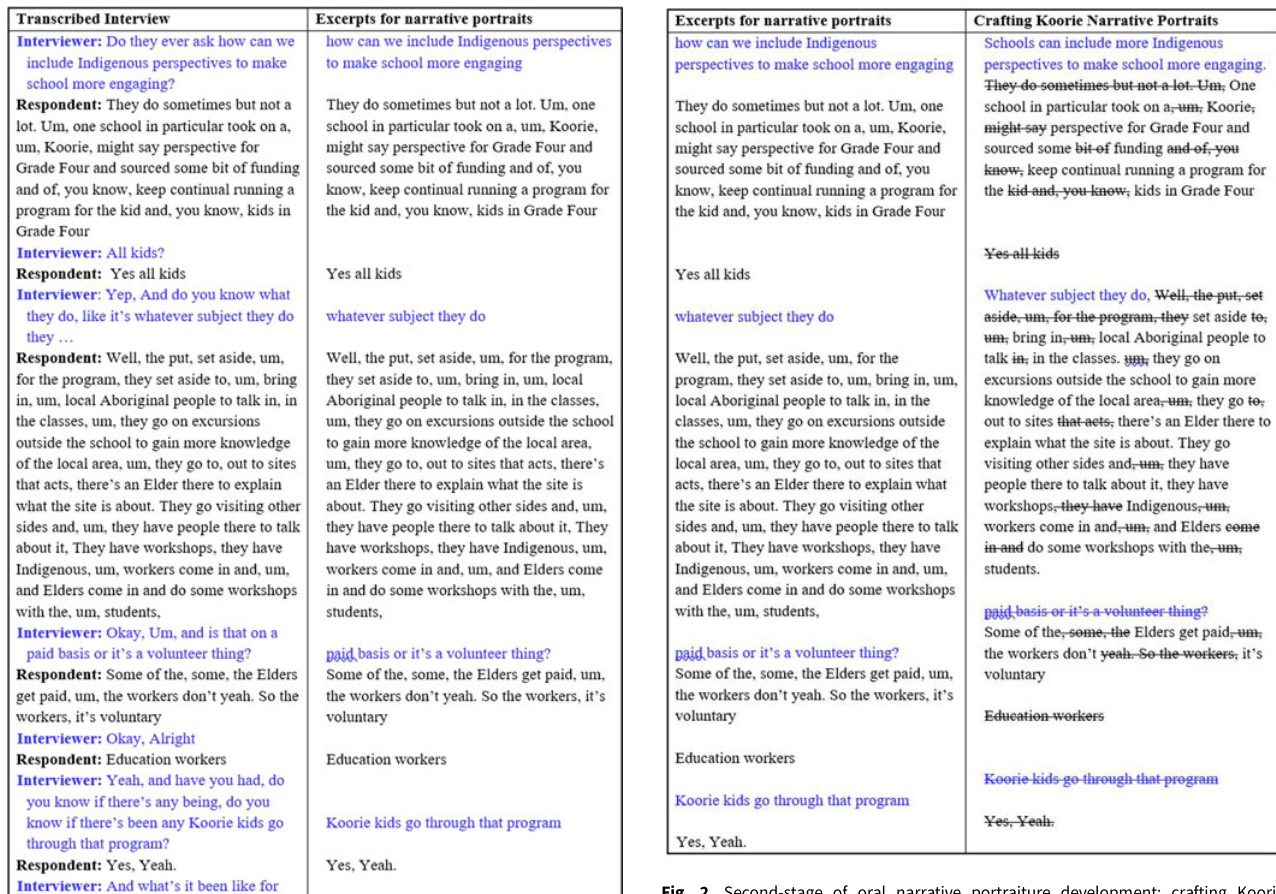
Fig. 2. Second-stage of oral narrative portraiture development: crafting Koorie